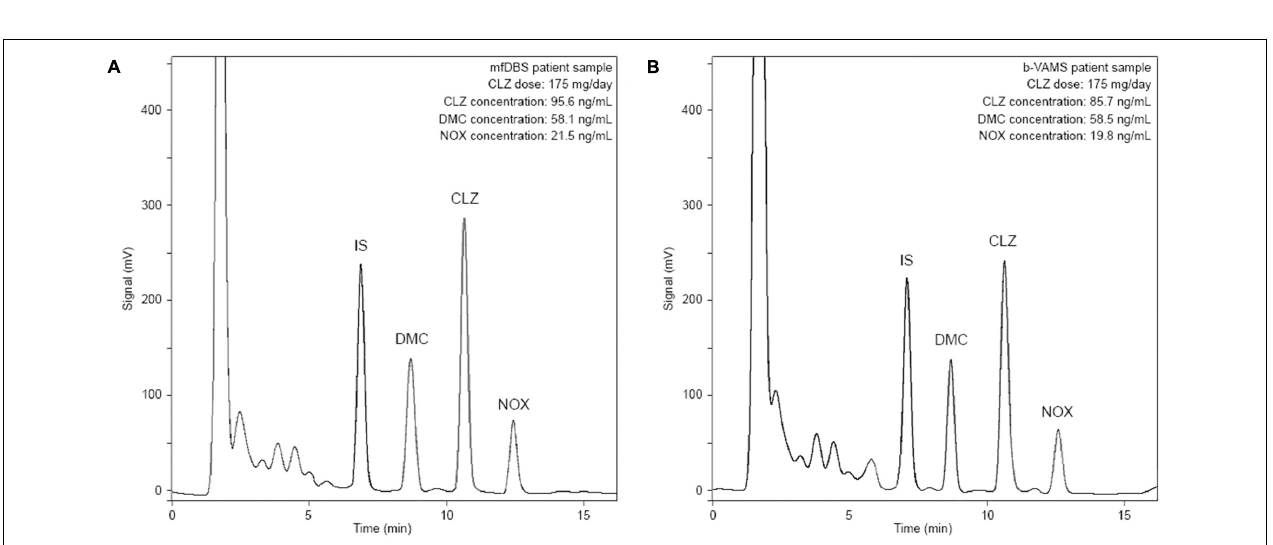
FIGURE 4 | Chromatograms obtained from the analysis of (A) mfDBS and (B) b-VAMS samples from a psychiatric patient treated with 175 mg/day of CLZ.